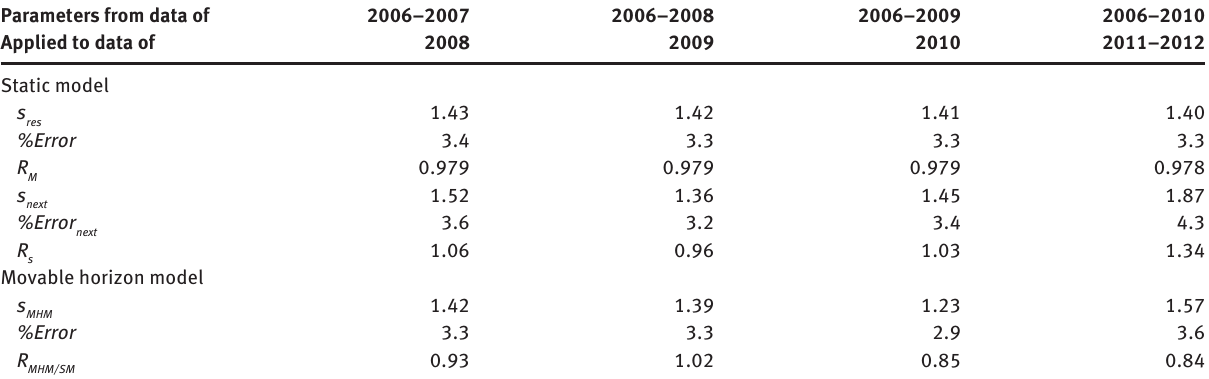
Table 5 Results of model Str_28_7